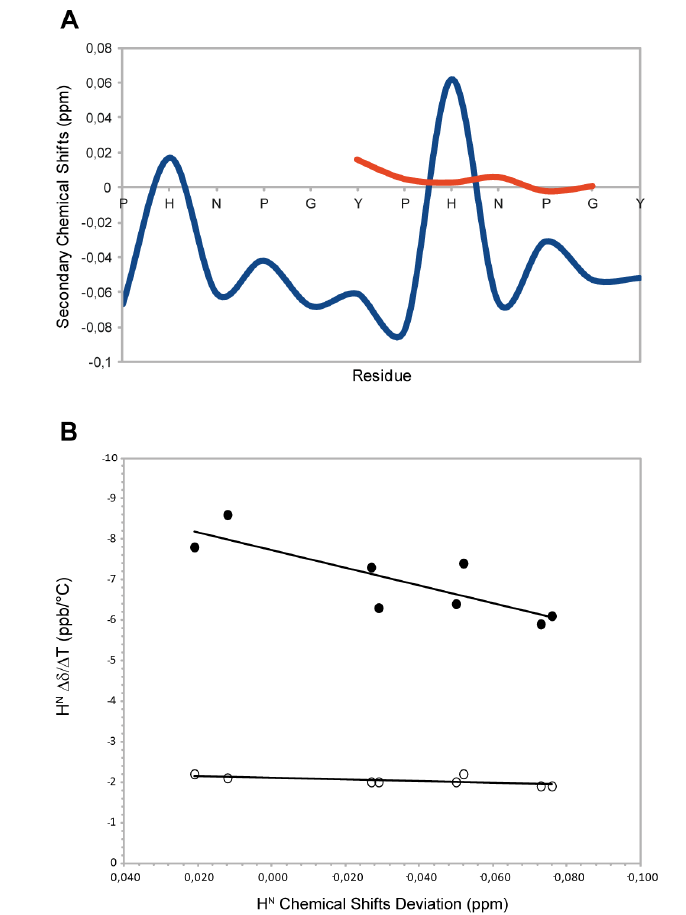
obtained by subtraction of intrincic Figure 2. ( A ) Secondary Chemical Shifts of H α statistical coil shifts recorded in 8 M urea for 2-HexaPY (Blue) and HexaYG (orange). ( B ) Amide H Chemical Shift Deviation (CSD)– Δδ / ΔΤ correlation for 2-HexaPY (filled N circles). The open circles shown define the condition for H N s involved in H-bond reported by Andersen and co-workers